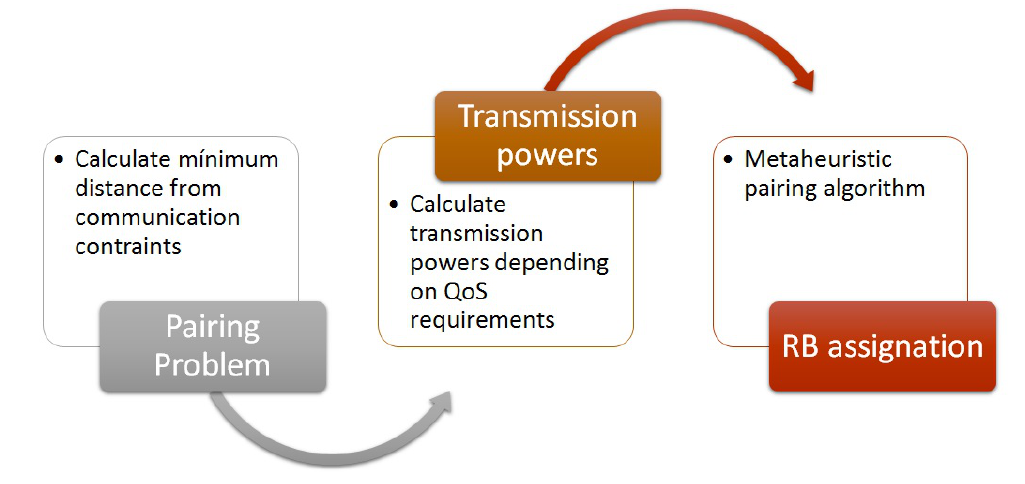
Figure 2. Resource Allocation